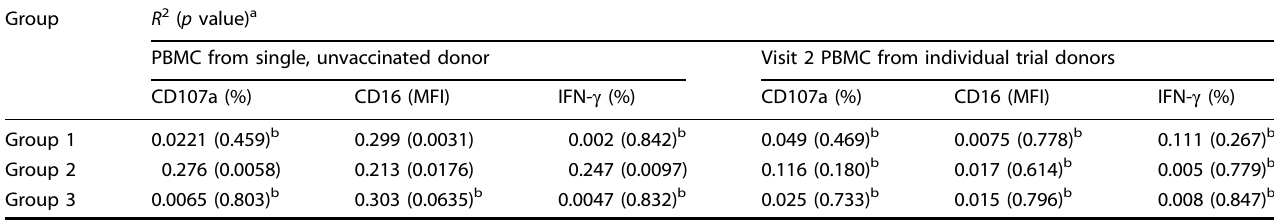
Table 3. Correlation between vaccination-induced anti-GP antibody concentration and NK cell responses for each vaccination group. Group R 2 ( p value) a PBMC from single, unvaccinated